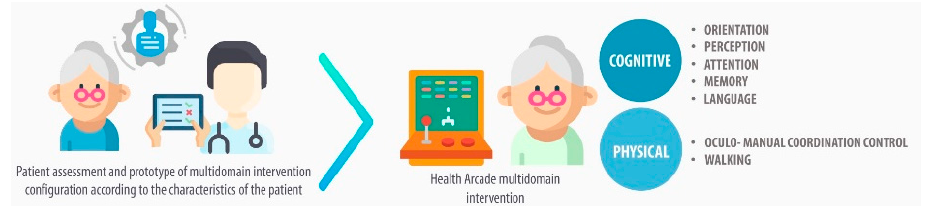
Figure 1. Health Arcade conceptual